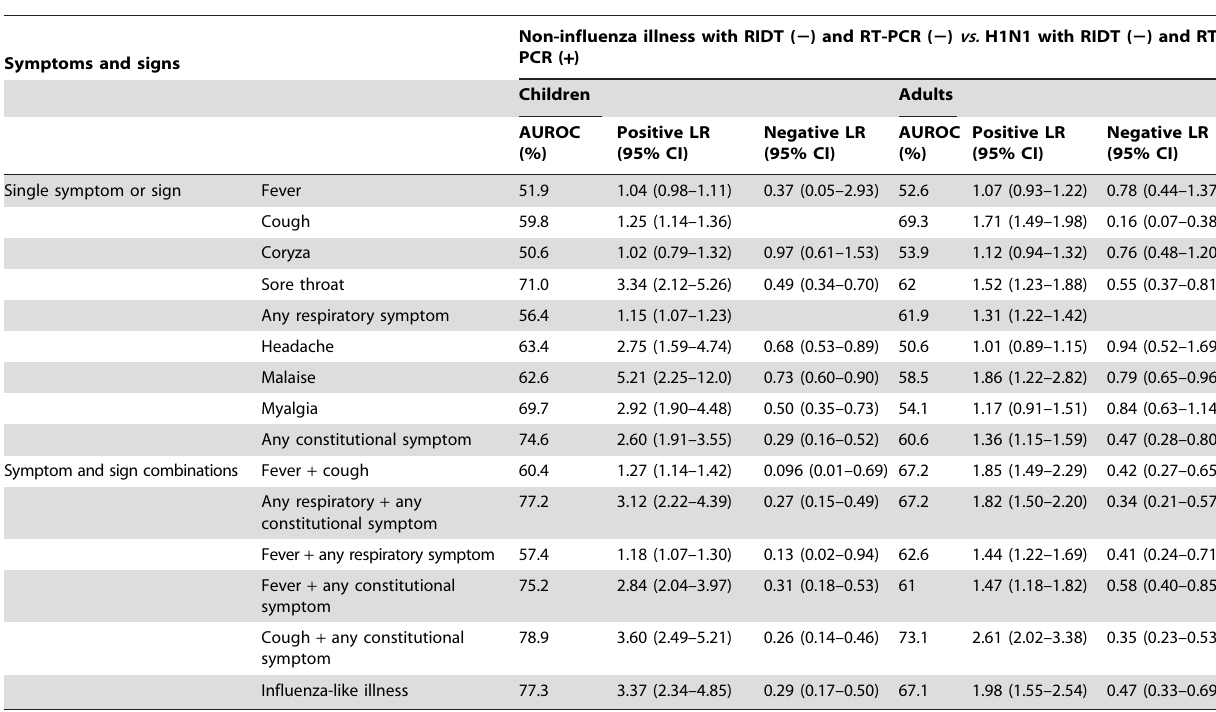
Table 4. Sensitivity and specificity of symptom and sign combinations for the identification of 2009 influenza A virus (H1N1) infection in patients with negative rapid influenza diagnostic tests